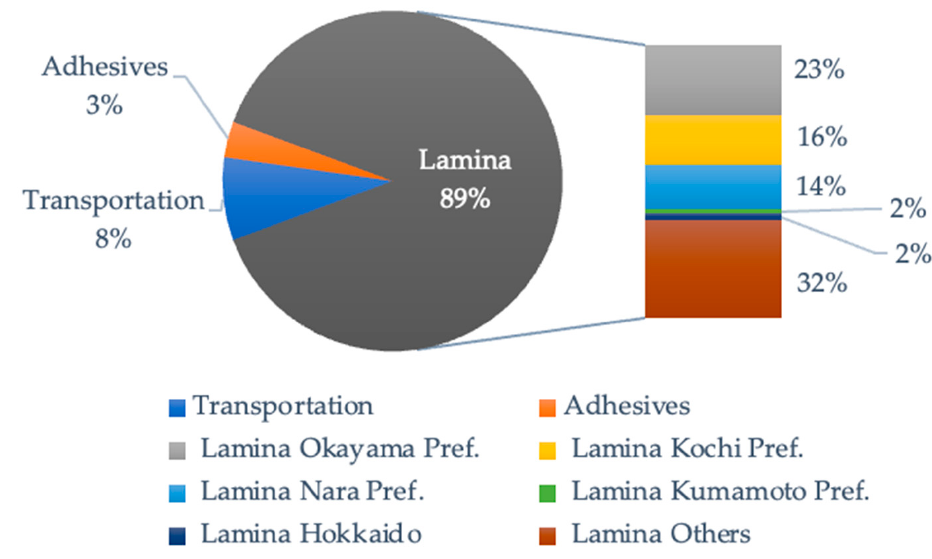
Figure 2. Cost composition of CLT raw materials and